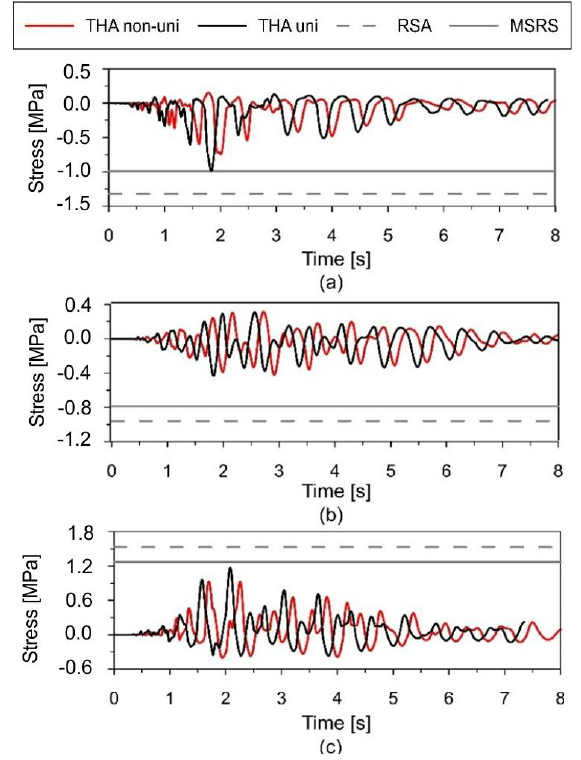
Figure 16. Comparison of extremal principal stresses obtained from different calculational methods for the mining-induced shock in the USCB region at the span zone elements: ( a ) W1; ( b ) W2; ( c ) W3.